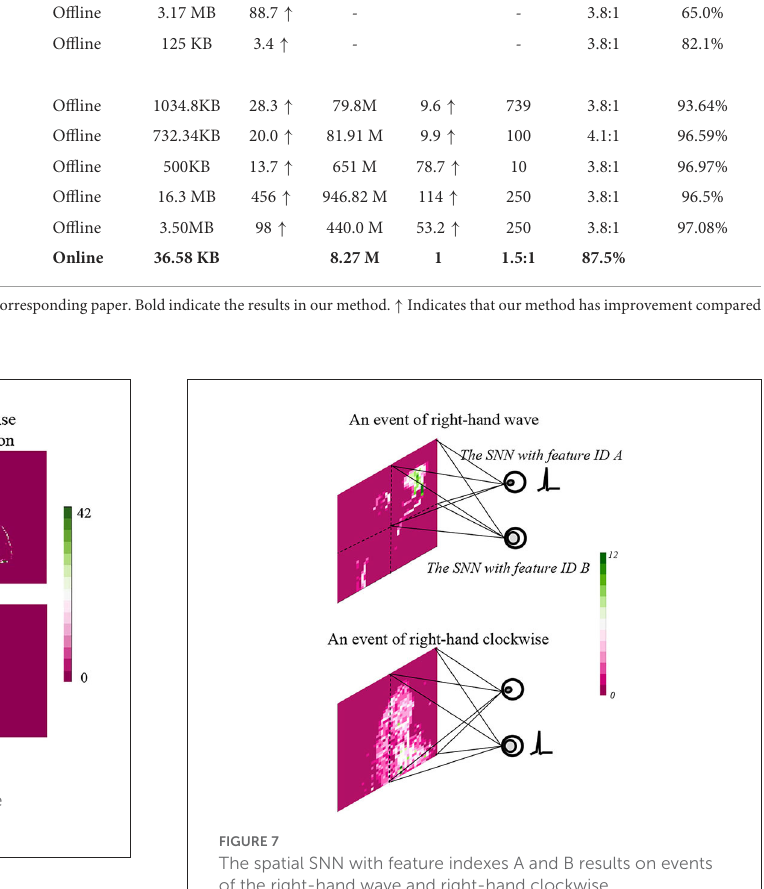
concluded the key design principles of the developed FSL paradigm: 1) a hierarchical structure-based network design involves prior human knowledge; 2) SNNs for global dynamic feature